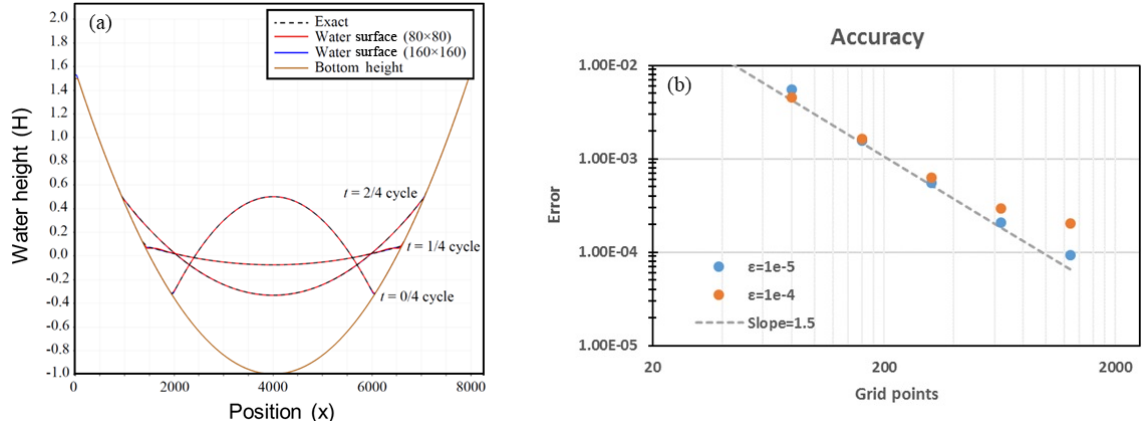
Figure 3. Parabolic bowl problem cross section with (cid:15) = 10 − 4 on (a) . Water depth error for parabolic bowl problem on (b) .